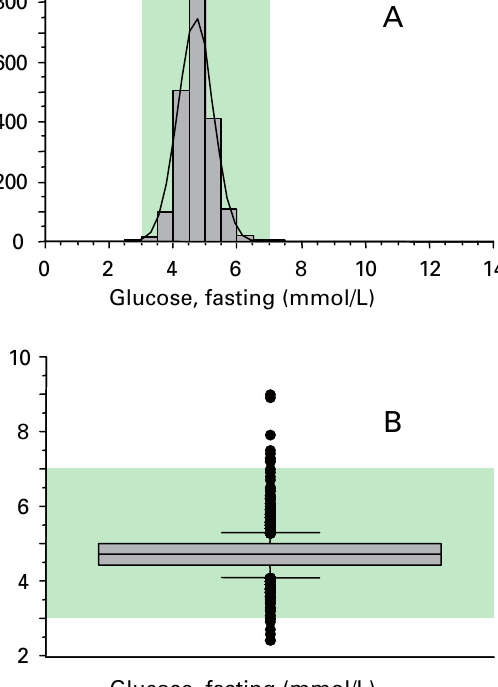
Elevated fasting glucose levels – indicators of a pre-diabetic state or overt diabetes? Fasting blood glucose levels were distributed normally (A). 0.4% (9/2064) of draftees had fasting glucose levels >7 mmol/L (B). The area shaded in green indicates the normal range.